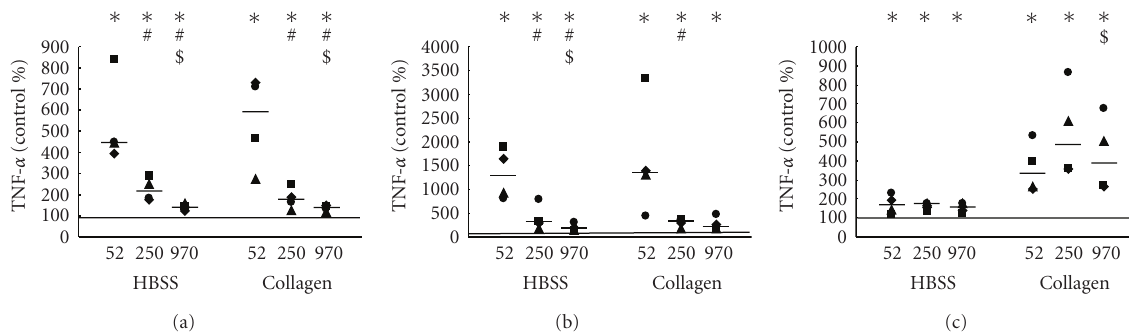
Figure 5: E ff ect of di ff erent MW HA (100 μ g/mL—a, b and 10 μ g/mL—c) on TNF- α production determined in absence and presence of collagen (0.16mg/mL) 2.5h (a) and 6 h (b, c) after addition of HA. The bold line represents the median, and data points from parallel measurementsare presented by the samesymbol. Statistically significantdi ff erences amongdi ff erent groups ( P < . 05)are marked by di ff erent symbols: ( ∗ ) statistical significance to control, (#) statistical significance to sample incubated with 52kDa HA, and ($) statistical significance between samples incubated with 250kDa and 970kDa